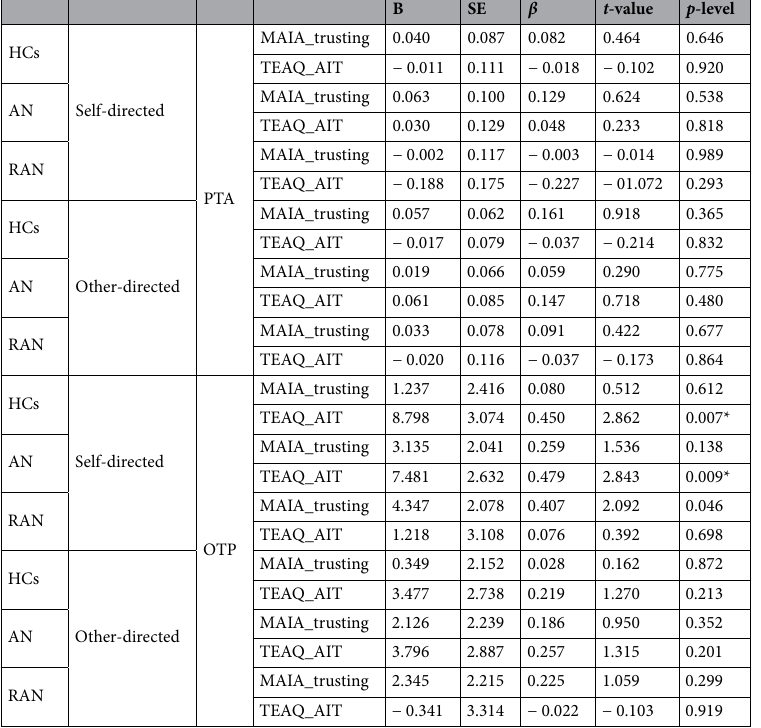
Table 4. Unstandardized coefficients of the multiple linear regression model for MAIA Trusting and TEAQ Attitude to intimate touch (AIT) for both PTA and OTP separated for each group (AN, RAN and HCs) and task (self-directed and other-directed touch). AN Current Anorexics, RAN Remitted Anorexics, HCs Healthy Controls, PTA Pleasant Touch Awareness, OTP Overall Touch Pleasantness, MAIA Multidimensional Assessment of Interoceptive Awareness, TEAQ Touch Experiences and Attitudes Questionnaire, AIT Attitudes to Intimate Touch. *Indicates p <